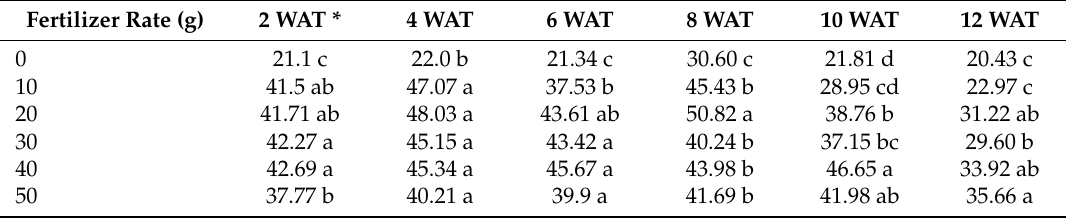
Table 3. Soil Plant Analytical Development values for a plant in a single pot with di ff erent rates of fertilizer at di ff erent weeks after fertilizer treatment during in Justicia brandegeana . Fertilizer Rate (g)